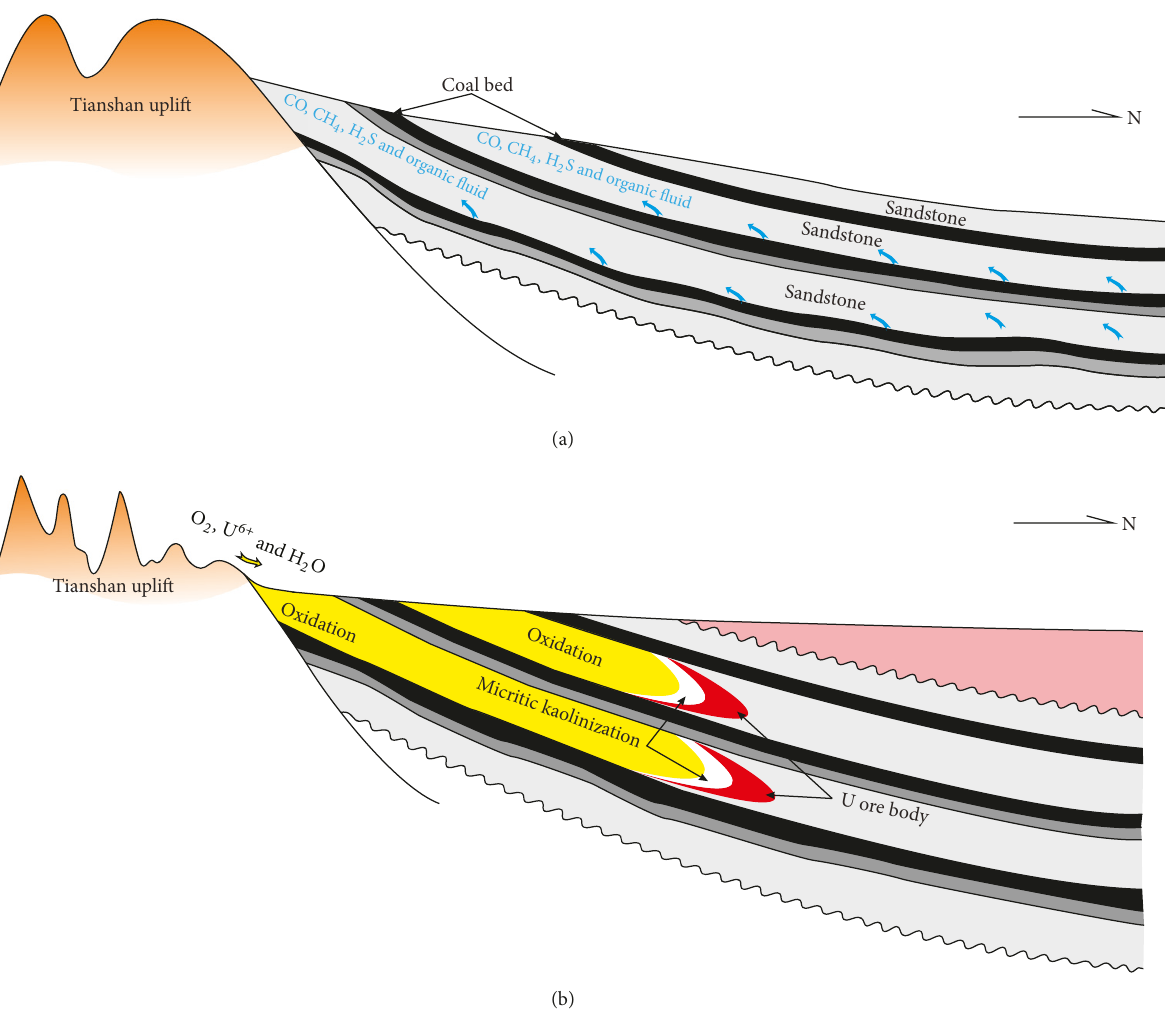
Figure 9: (a) Organic fluid containing CO, CH 4 , and H 2 S occurred from coal beds and carbonaceous mudstones during shallow-burial diagenetic stage and entered into sandstones while flowing from the basin bottom to top. (b) Meteoric water containing U and O 2 infiltrated interlayered sandstones, forming oxidation zones, white micritic kaolinization zones, and uranium